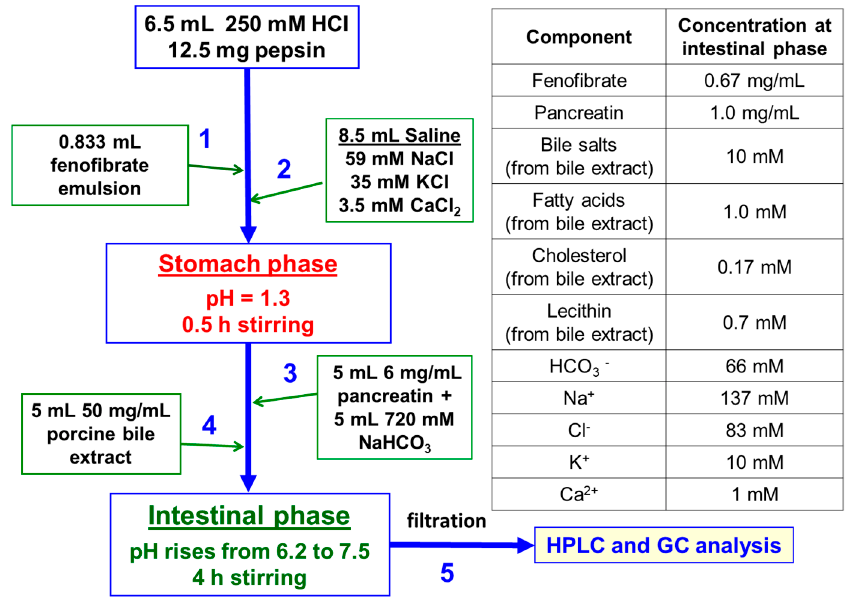
Figure 1. Schematic representation of the two-stage in vitro digestion model. Inset (right hand side): concentrations of the components at the intestinal phase.